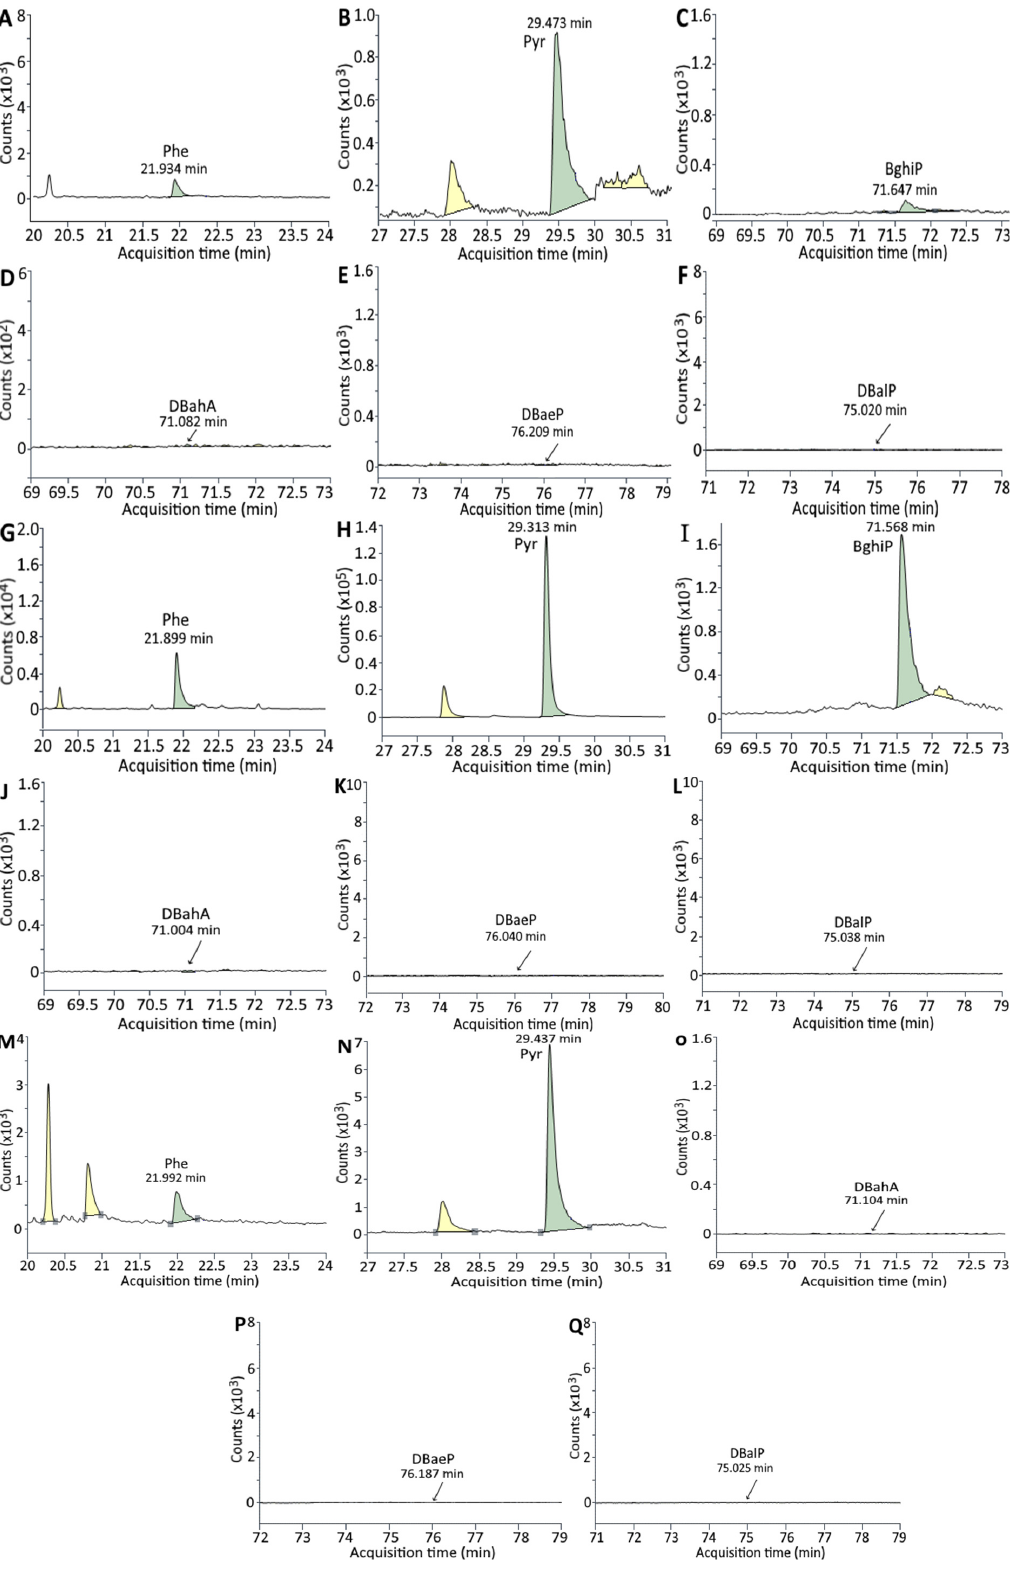
Figure 3. GC-MS/MS chromatogram of PAHs in marinated pork after 24 h marinating ( A – F ), marinated pork with 0.5% cinnamon powder after 24 h marinating ( G – L ) and marinated pork with 0.5% green tea powder after 24 h marinating ( M – Q ), as detected by SRM mode. ( A , G , M ): Phe; ( B , H , N ): Pyr; ( C , I ): BghiP; ( D , J , O ): DBahA; ( E , K , P ): DBaeP; ( F , L , Q ):